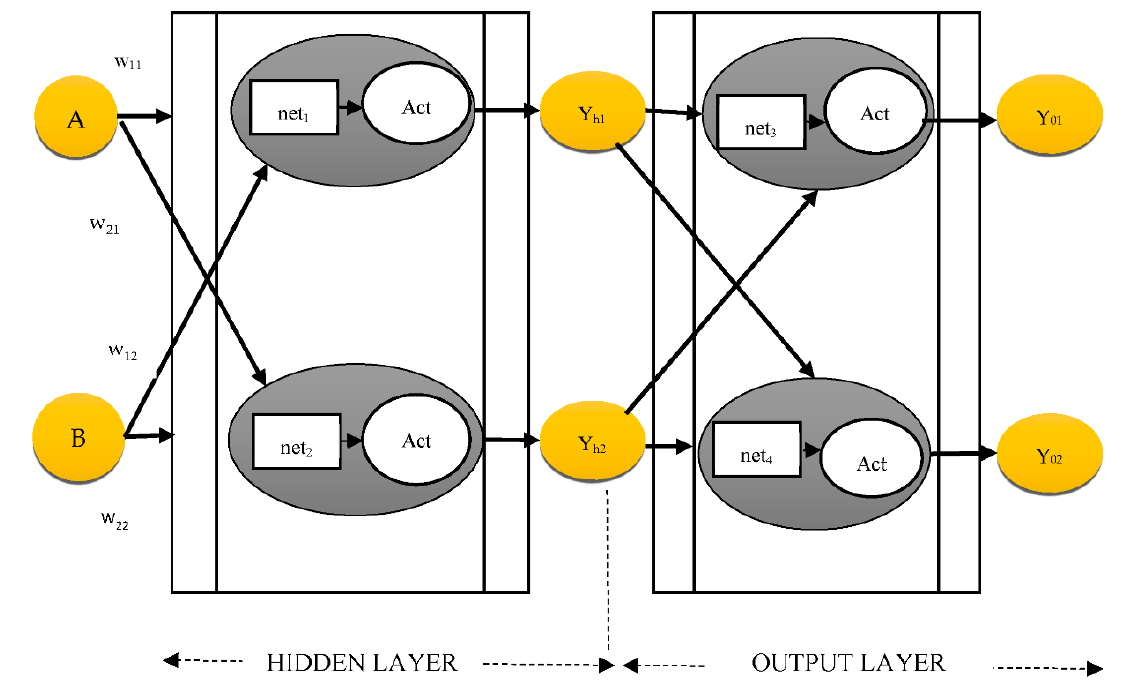
Figure 3. MLP procedure (where Act signifies activation function, w represents weights, and Net denotes network) .